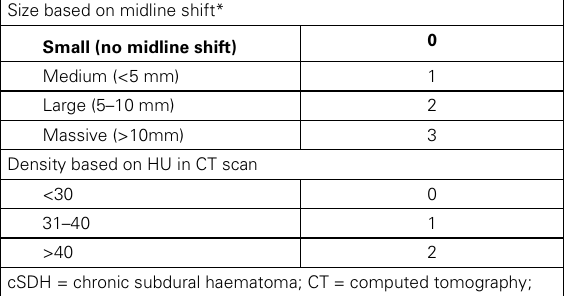
Table 2: Proposed radiological grading system of cSDH for evaluating the success of corticosteroid treatment (adapted from Thotakura et al.